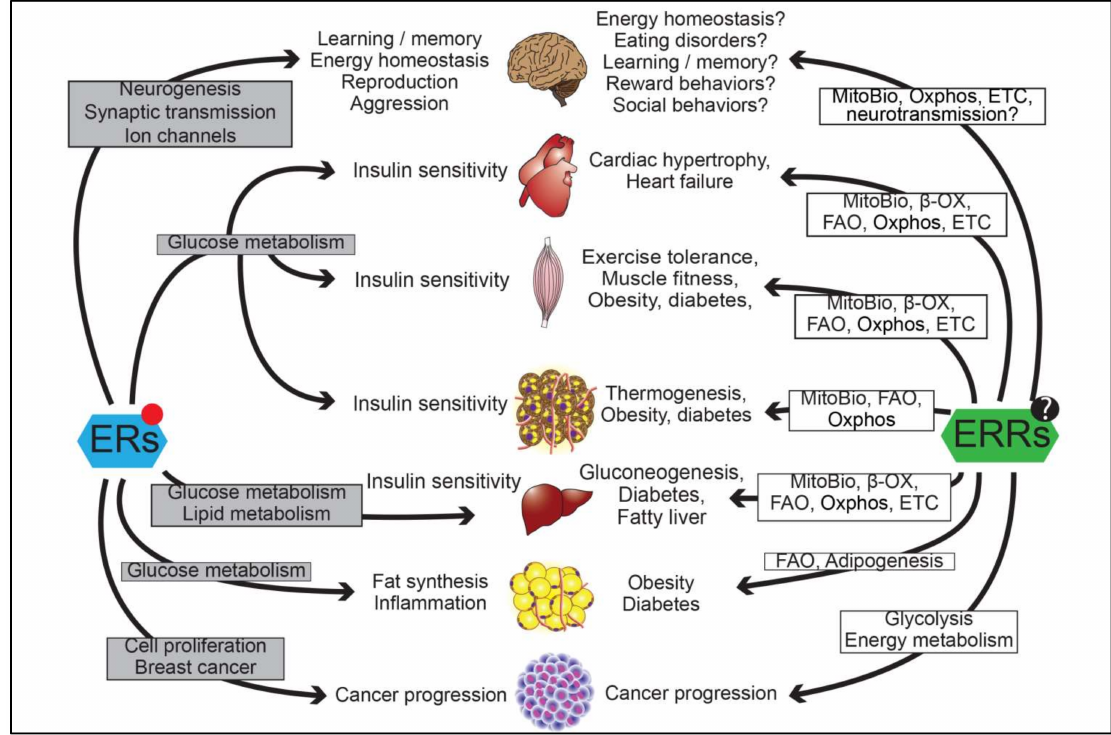
Figure 3. ERs and ERRs regulate a variety of important cellular functions and any disruption in these processes can lead to different pathological conditions. MitoBio, mitochondrial biogenesis; β -OX, beta-oxidation; FAO, fatty acid oxidation; Oxphos, oxidative phosphorylation; ETC, electron transport chain. Red dot indicates estrogens and “?” indicates unknown ligands for